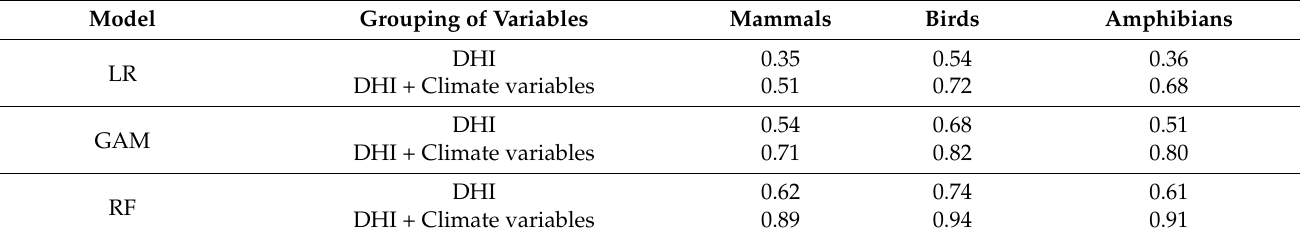
Table 3. Simulation of species richness with DHIs, and climate variable model results using LR, GAM, and RF (The numbers in the table represent the R 2 of the model at p <